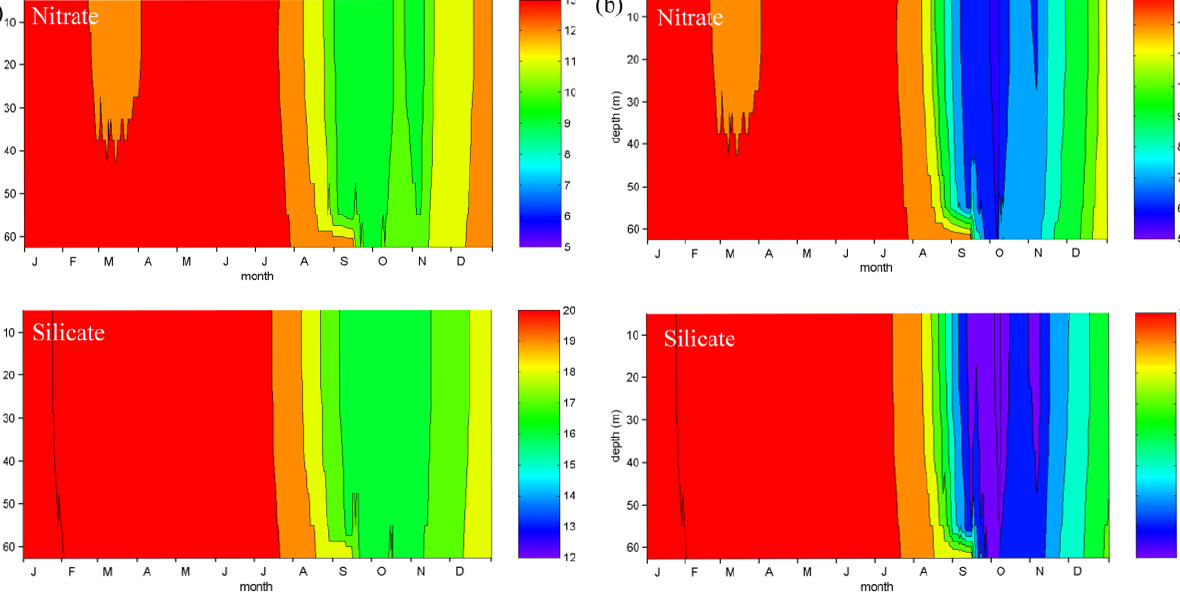
decreasing atmospheric CO 2 by ∼ 0.01 Pg C (Hamme et al.,